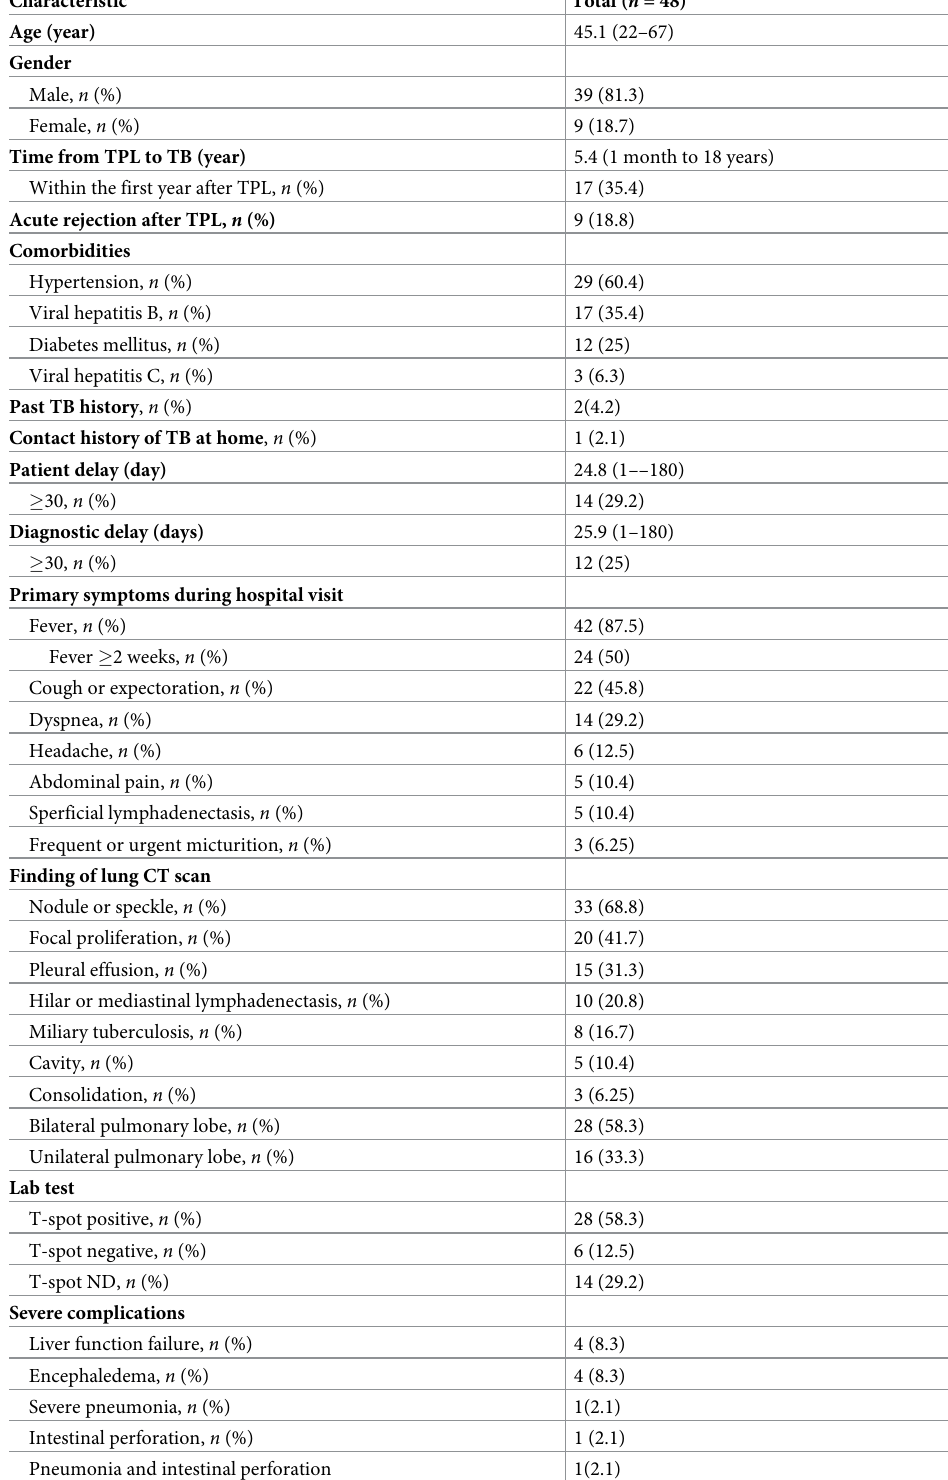
Table 1. Demographic and clinical characteristics of 48 patients with active tuberculosis after